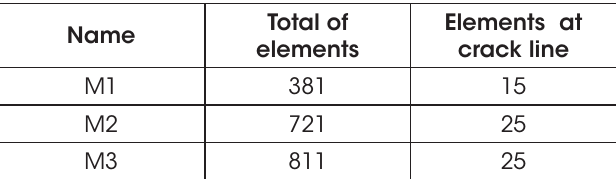
Meshes for the three-point bending test